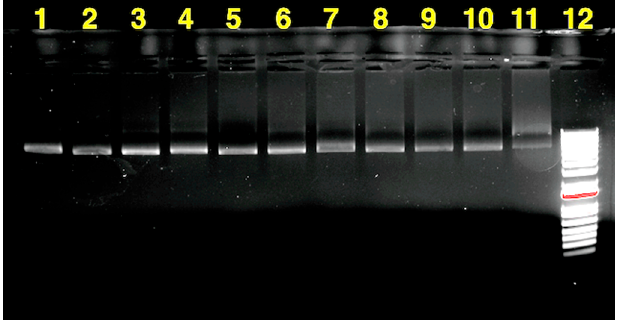
Figure 14. Serum stability studies of PEG- b -CPCL-70:pDNA nanocomplexes at 200:1 mass ratio at various time points. Time points were assigned to each lane as follows: (1) 0 min, (2) 5 min, (3) 15 min, (4) 30 min, (5) 45 min, (6) 1 h, (7) 2 h, (8) 3 h, (9) 4 h, (10) 5 h, (11) 24 h, and (12) molecular weight marker (DNA ladder).